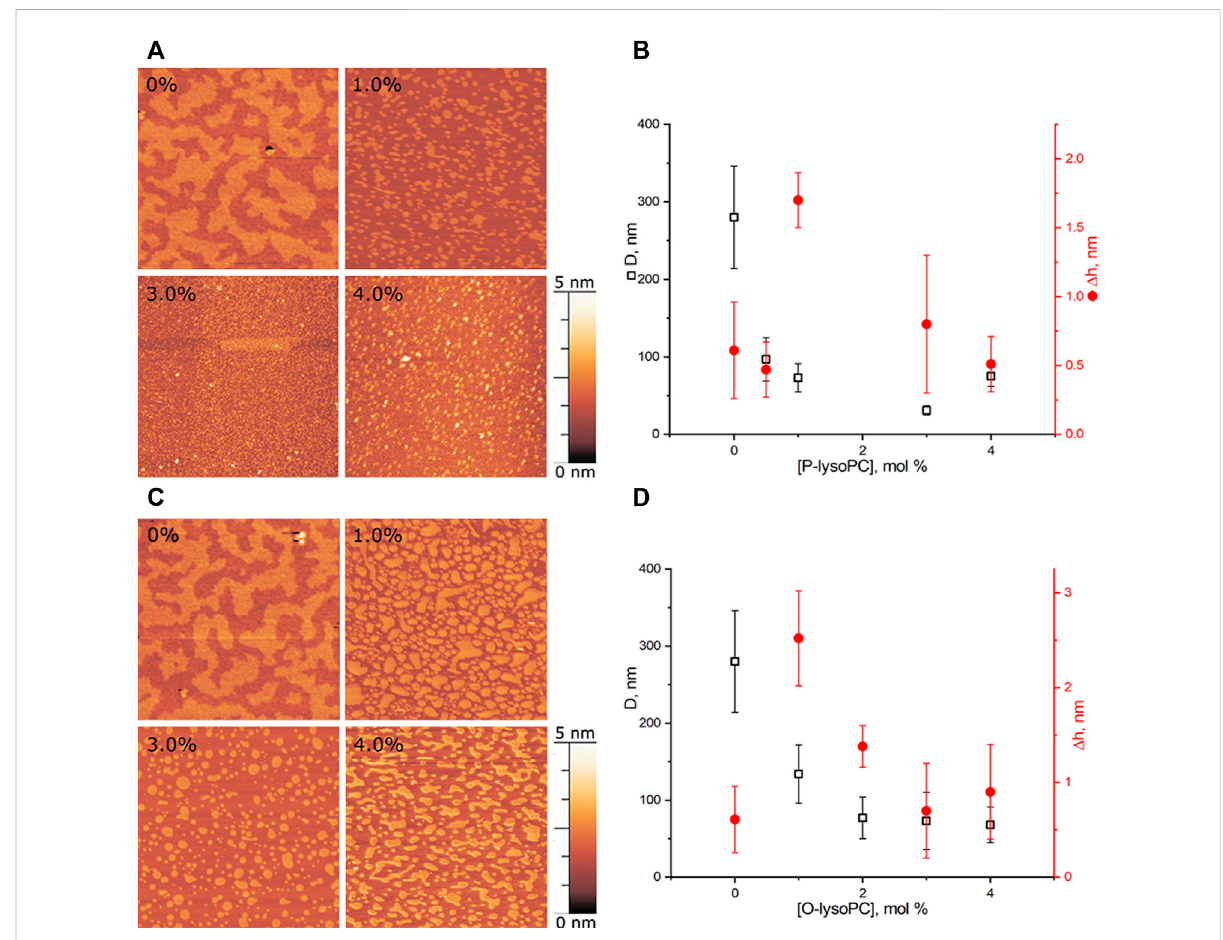
FIGURE 3 Lysolipids intheeSM/DOPC/Chol= 1:1:1membrane (A) AFM images ofthemembranewithP-lysoPC. (B) Dependence oftheaverage diameter of rafts on the molar fraction of P-lysoPC in the membrane. (C) AFM images of the membrane with O-lysoPC. (D) Dependence of the average diameter of rafts (black) and their height above the surrounding membrane (red) on the molar fraction of O-lysoPC in the membrane. Size of each AFM image is 3 μ m × 3 μ m. Amount of lysolipids in the membrane in mol% is indicated in each